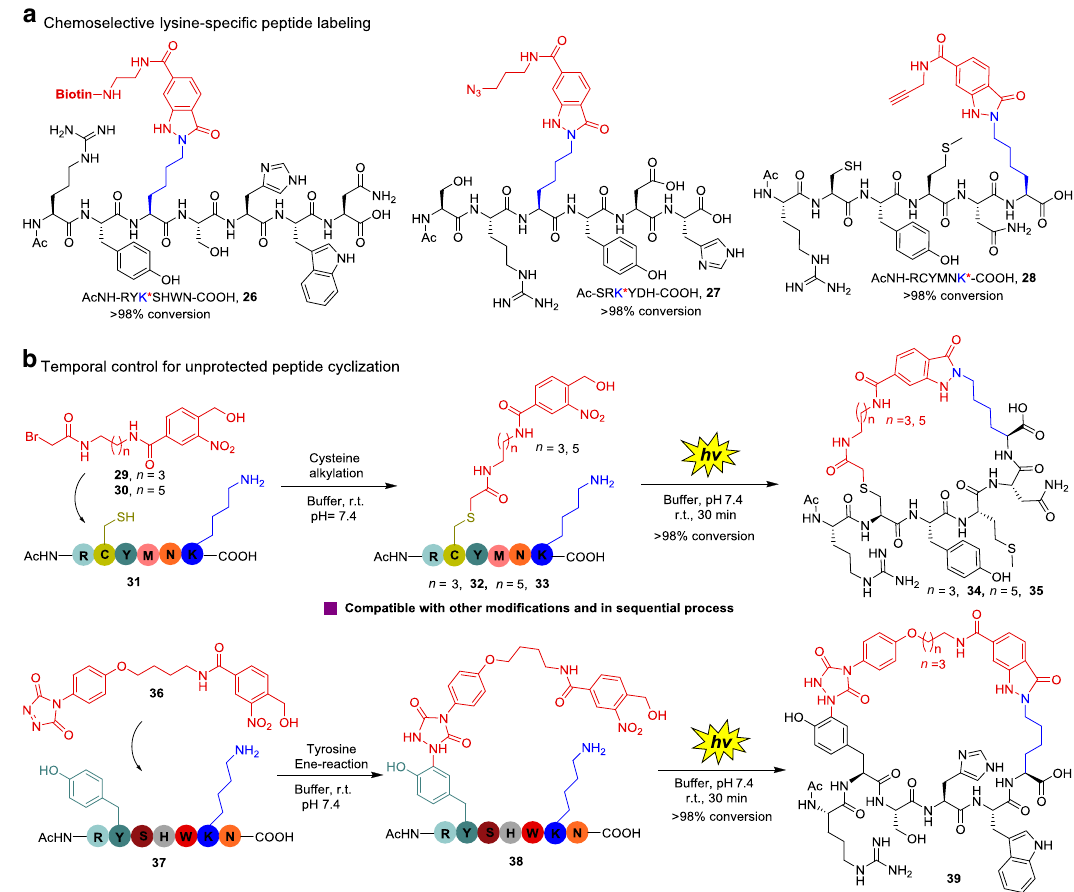
Fig. 4 Light-induced chemoselective and temporal control of unprotected peptide labeling and cyclization. a Lysine-speci fi c unprotected peptide labeling, reaction conditions: peptides and o -NBA derivatives in 100 mM PBS/MeOH (9:1, pH = 7.4) were treated with 365 nm UV light for 15 min and incubated at 25 °C for 30 min, conversions were determined by reverse-phase HPLC as an average of three independent trials, see Supplementary Information for HPLC trace. For cyclization peptide 28 DTT was used for reducing cysteine dimerization after the reaction. b Lysine-speci fi c unprotected peptide cyclization, see Supplementary Information for HPLC trace, conversions were determined as in a